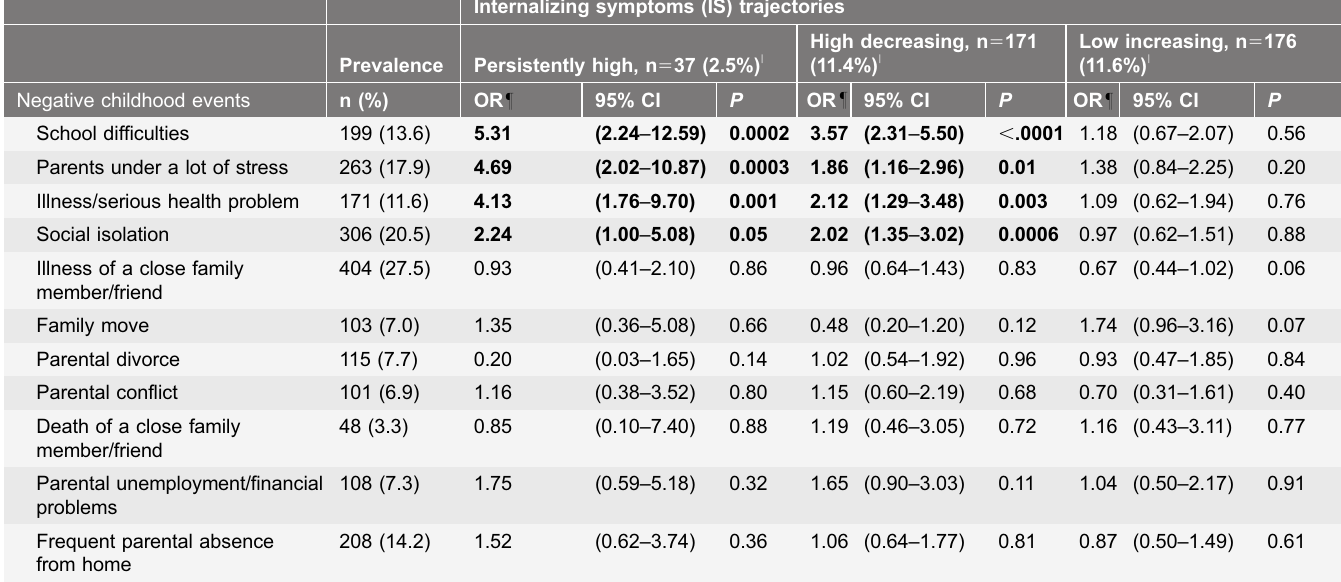
Table 3. Specific negative events in childhood and internalizing symptoms trajectories (French TEMPO study, 1991–2009, n 5 1503, multivariate ORs adjusted for sex, age at baseline, and parental history of depression, 95%